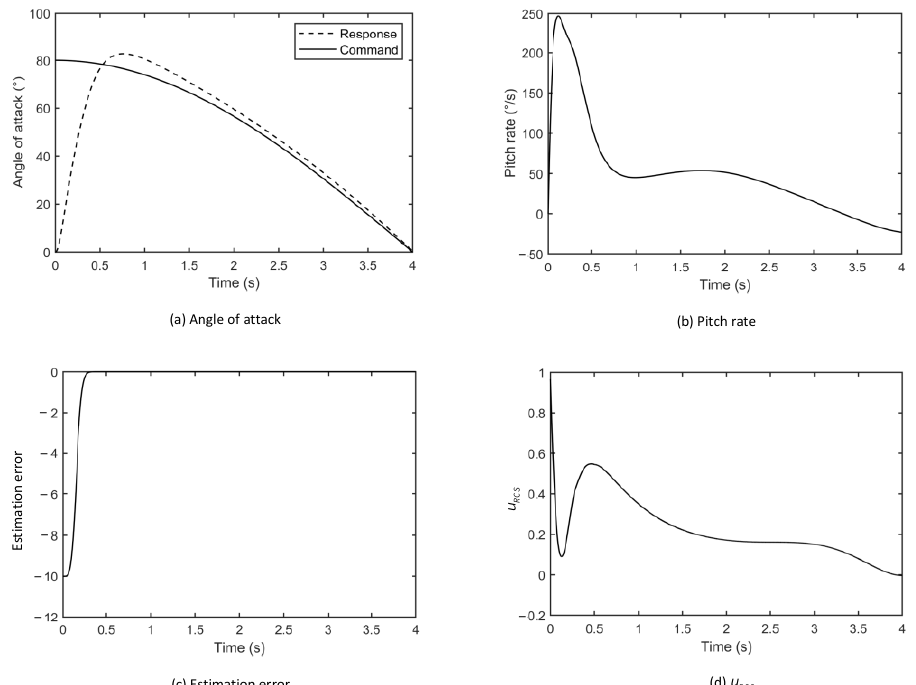
Figure 5. Responses under traditional I&I method.